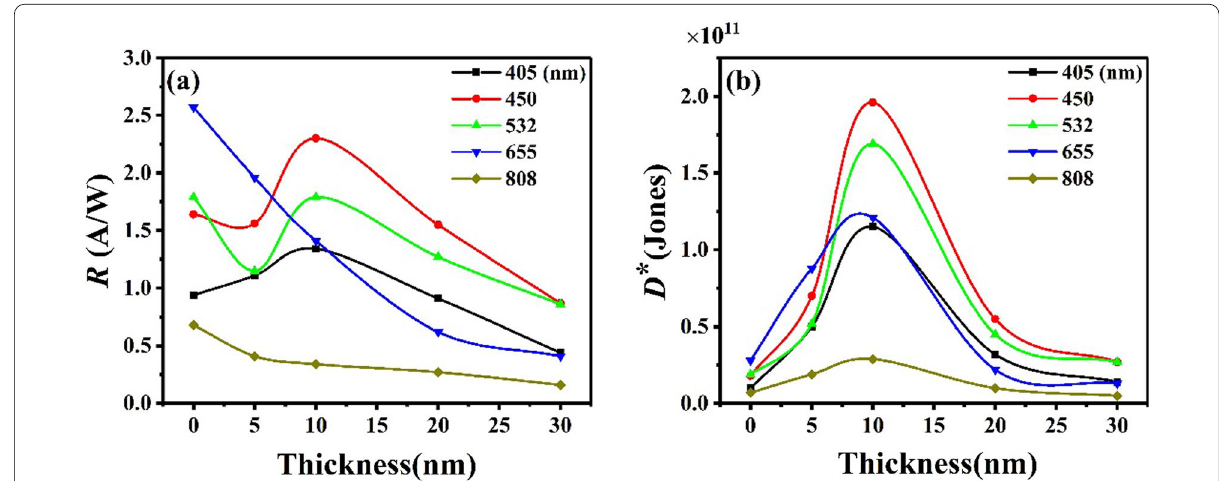
Fig. 7 The dependences of a photoresponsivity R on the different C 60 thicknesses, b specific detectivity D * on the thickness for different wavelengths. All results were obtained at a reverse bias voltage of